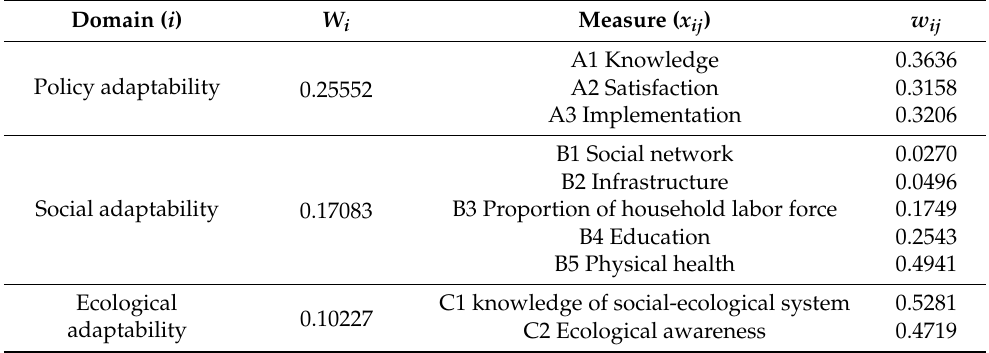
Table 1. Adaptability index values of residents in the QMNPP. The policies included the following: “Returning the grain plots to forestry and grass”, “Fodder–livestock balance system”, “Eco-migration”, “Eco-compensation”, etc. B3 = Labor force ÷ total number of family. B4 = Number of high school or above ÷ total number of family. D3 = 5 ≥ 70,000; 4 = 50,000–70,000; 3 = 30,000–50,000; 2 = 10,000– 30,000; 1 ≤ 10,000. Natural assets owned by households include the number of cattle and sheep, grassland area and so on. D5 = Productive consumption ÷ total annual consumption of a